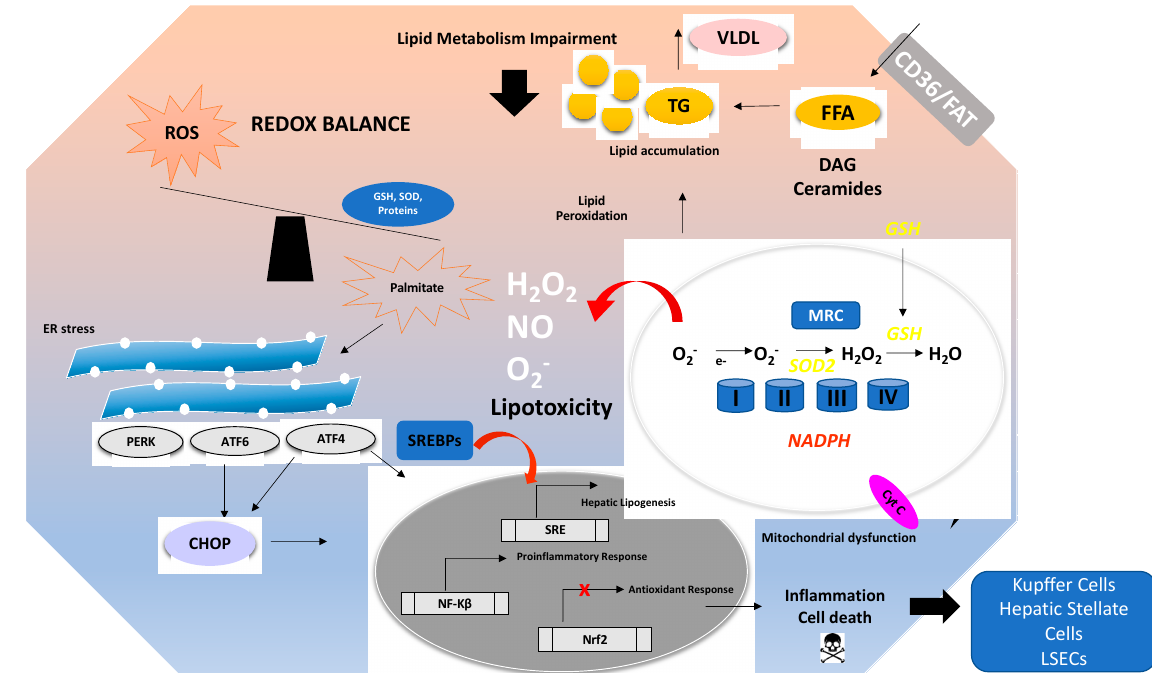
Figure 1. Overview of oxidative stress and antioxidants in the context of non-alcoholic fatty liver disease (NAFLD). The pathogenesis of NAFLD is a multifactorial process involving several mechanisms, ultimately leading to a disturbed redox balance. Impairment of lipid metabolism, e.g., by excessive dietary intake of fat and carbohydrates, leads to steatosis. This can be aggravated by insulin resistance. Free fatty acids (imported by, e.g., CD36 or FAT) such as palmitate cause lipotoxicity by increasing the levels of toxic lipid species such as ceramides and diacylglycerols (DAG). Mitochondrial dysfunction, impairment of β -oxidation, and endoplasmic reticulum (ER) stress can all increase the generation of ROS leading to lipid peroxidation. ER stress induces the UPR, i.e., Unfolded Protein Response. Sustained ER stress and sustained activation of the UPR will trigger activation of the ER stress proteins PERK, ATF6, ATF4, and CHOP, leading to a proinflammatory response and activation of cell death pathways in hepatocytes. ER stress might lead to the activation of sterol regulatory element-binding protein 1C (SREBP1c) and further translocation to the nucleus, thus promoting hepatic lipogenesis. The impaired redox balance also affects the antioxidant response (e.g., the Nrf2 pathway) and leads to decreased levels of antioxidants (e.g., GSH and